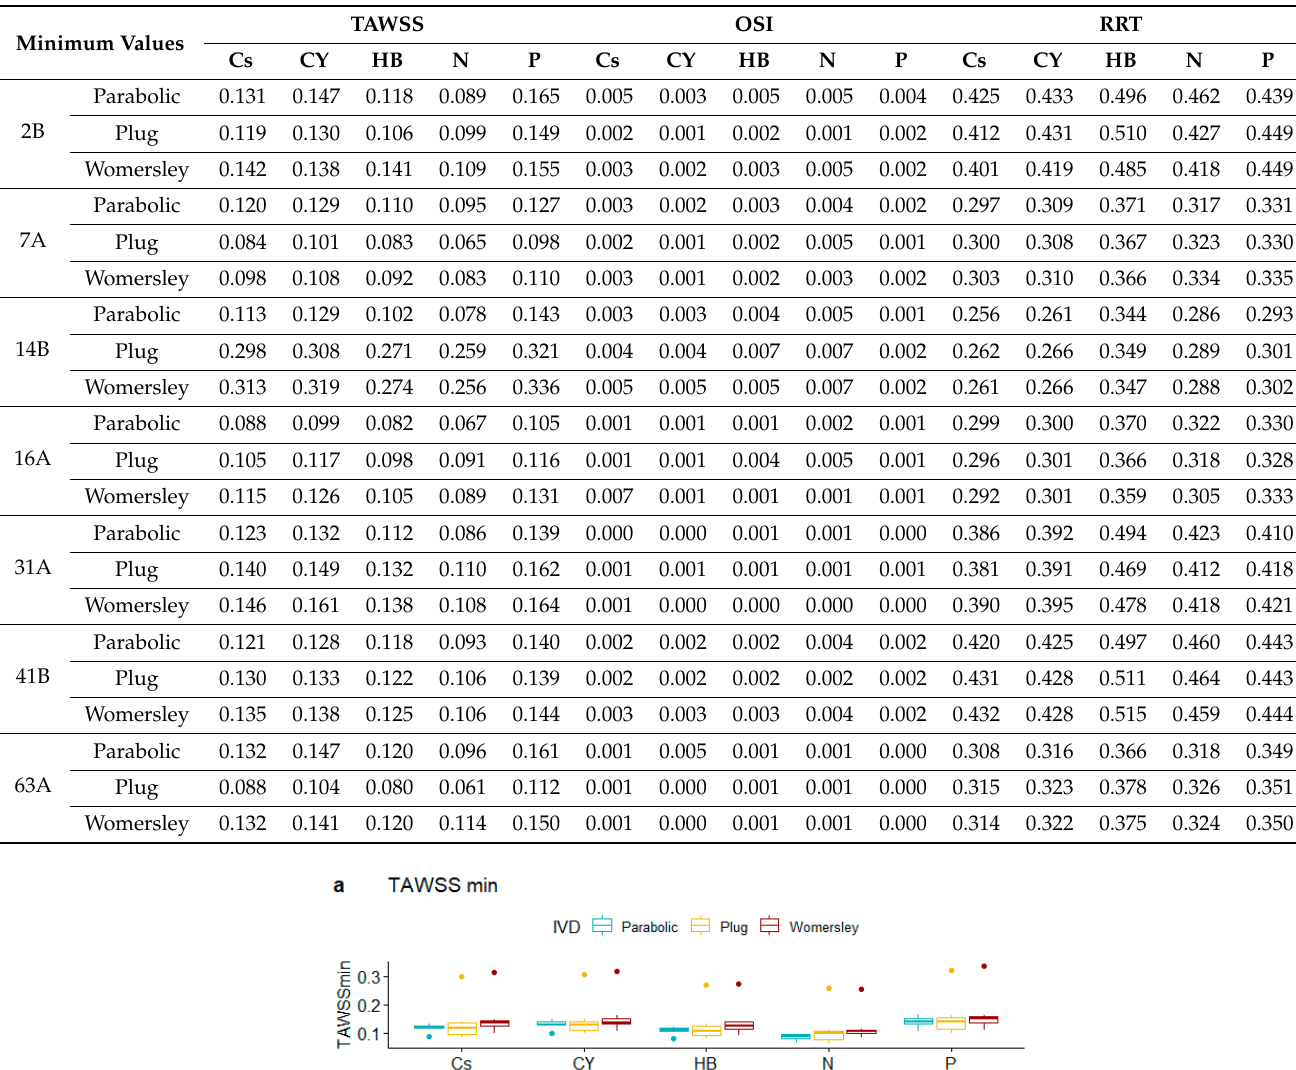
Table 9. Minimum values and TAWSS, OSI, and RRT.